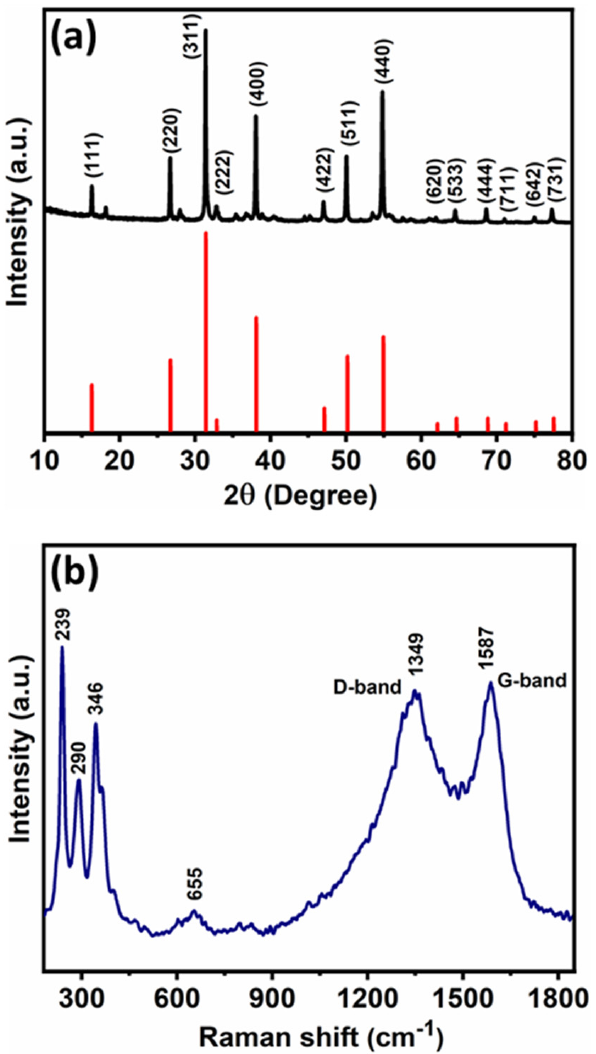
Figure 1. ( a ) Powder X-ray diffraction pattern, and ( b ) Raman spectra of FNS@GC composite. Further, Raman spectroscopy was carried out for the FNS@GC composite (Figure